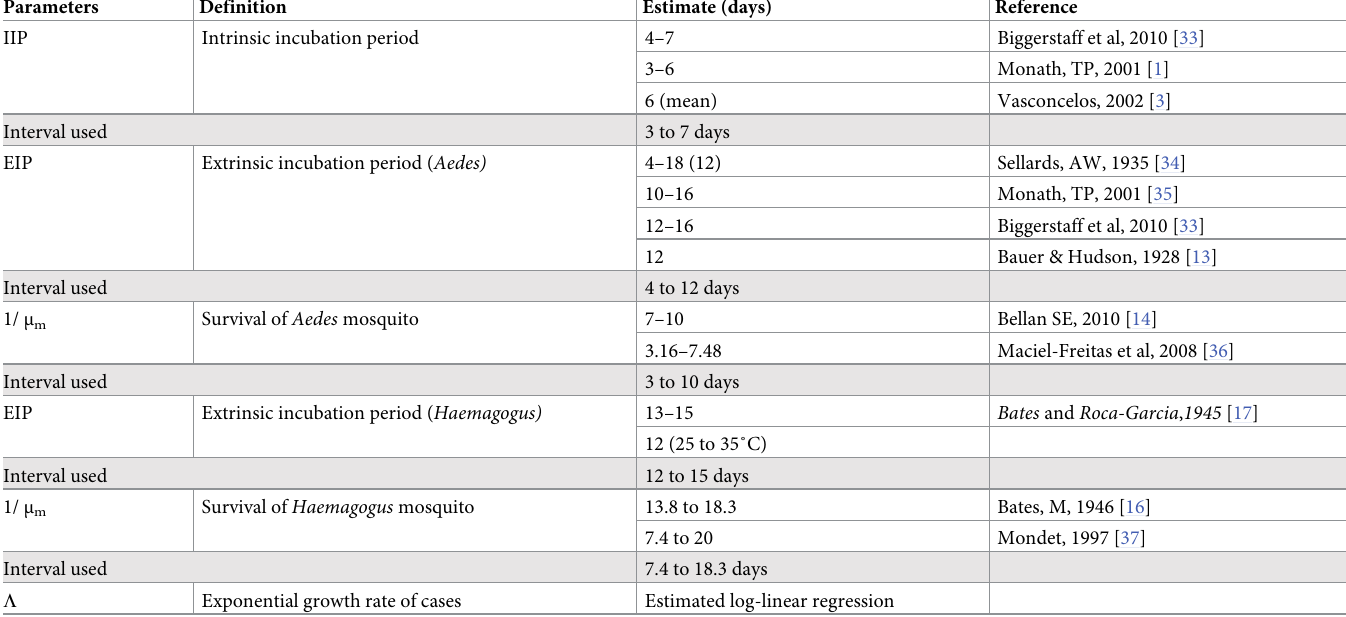
Table 1. Parameters of the natural history of yellow fever, their definitions and range of values used in the